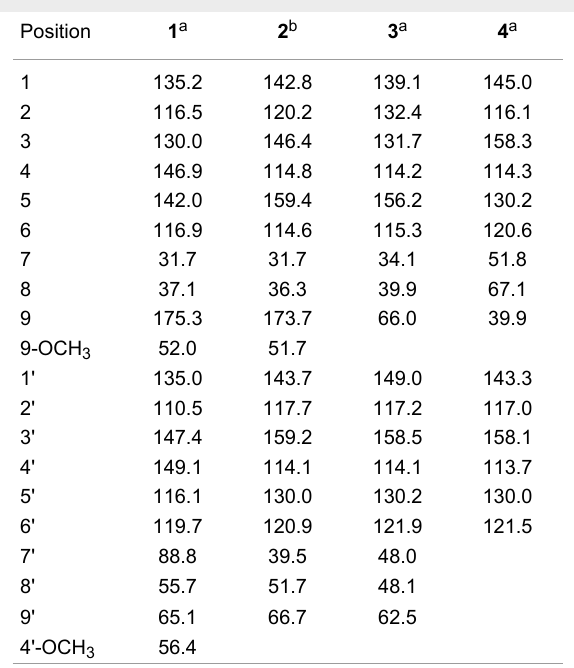
Table 2: 13 C–NMR data for compounds 1 – 4